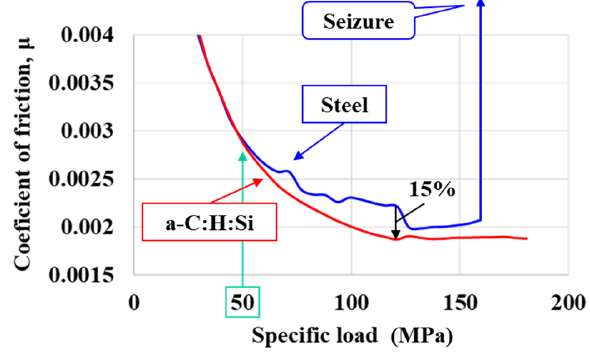
Figure 10. Change in torque at various specific load.